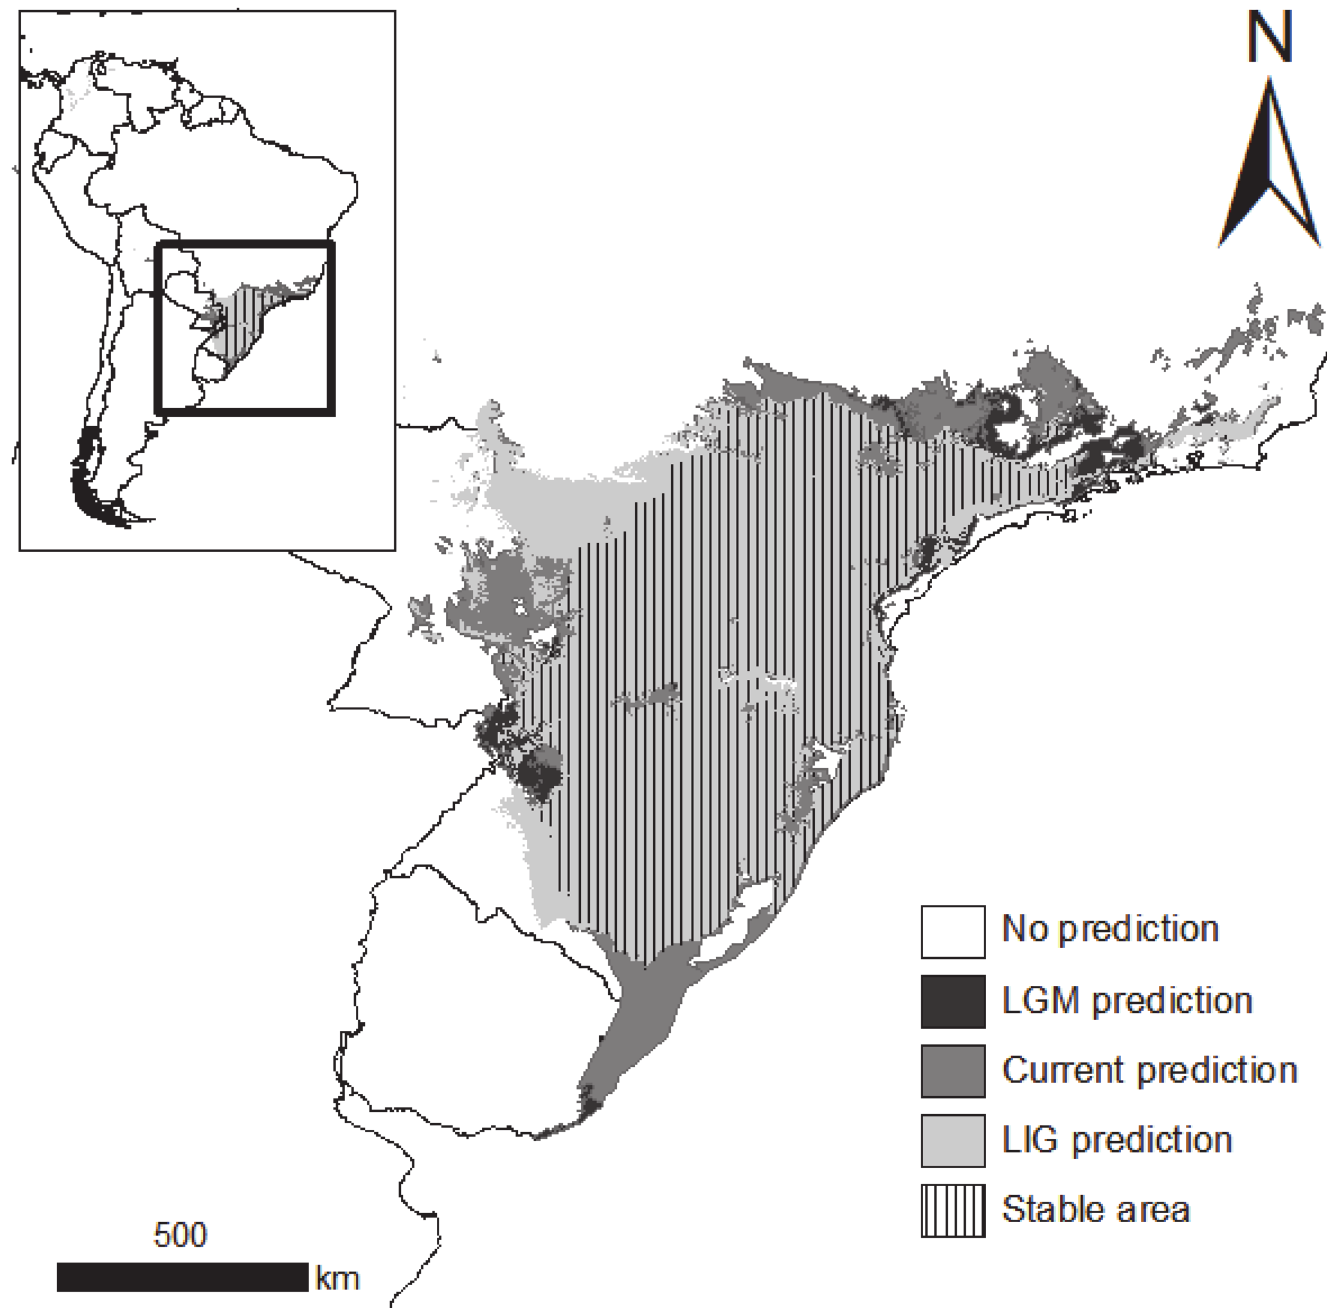
Fig 5. Modeled distributions of Araneus omnicolor . The distributions in the current and paleoclimate [21 Kya (LGM) and 120 Kya (LIG)] scenarios are represented. The hatched area represents the stable occurrence region during all periods.